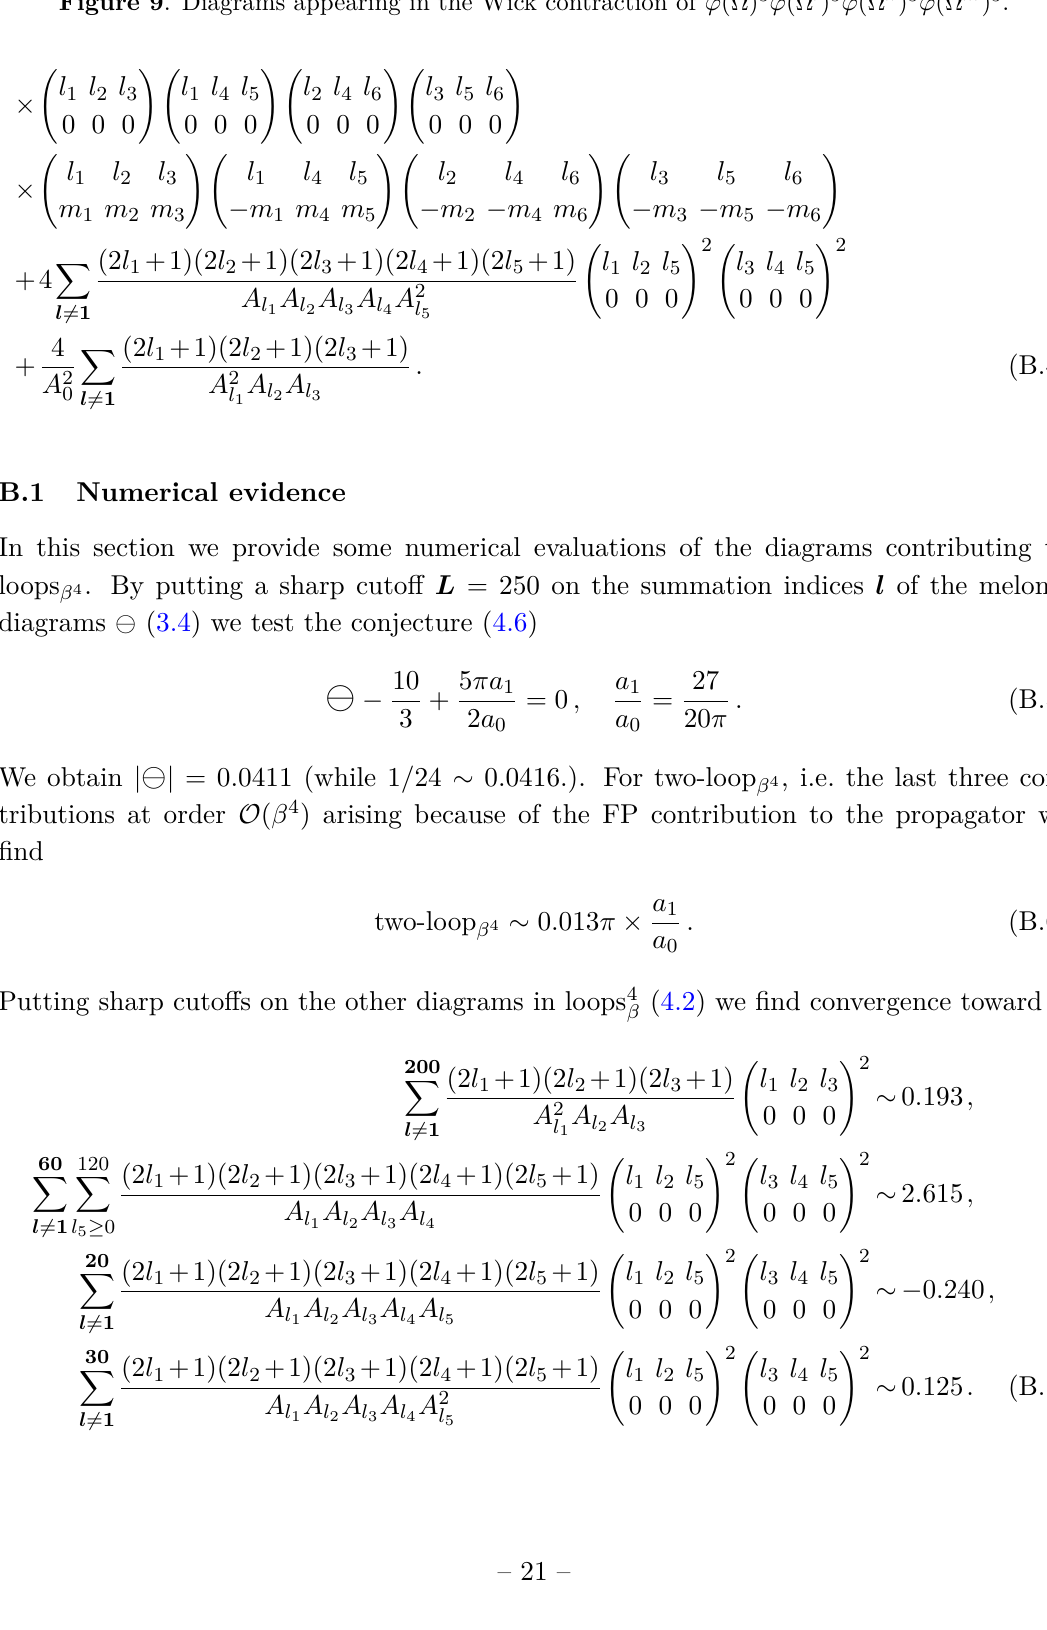
Figure 9 . Diagrams appearing in the Wick contraction of ϕ (Ω) 3 ϕ (Ω 0 ) 3 ϕ (Ω 00 ) 3 ϕ (Ω 000 ) 3